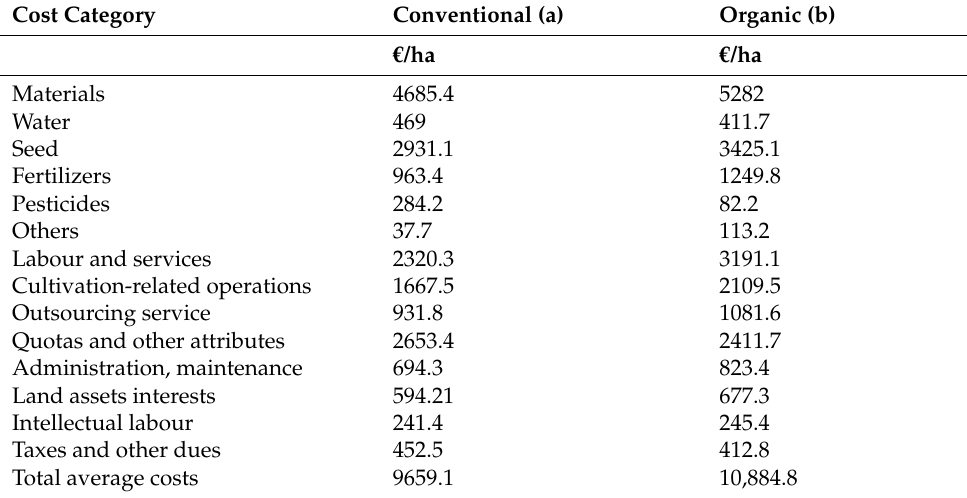
Table 7. Production costs of early potato growing